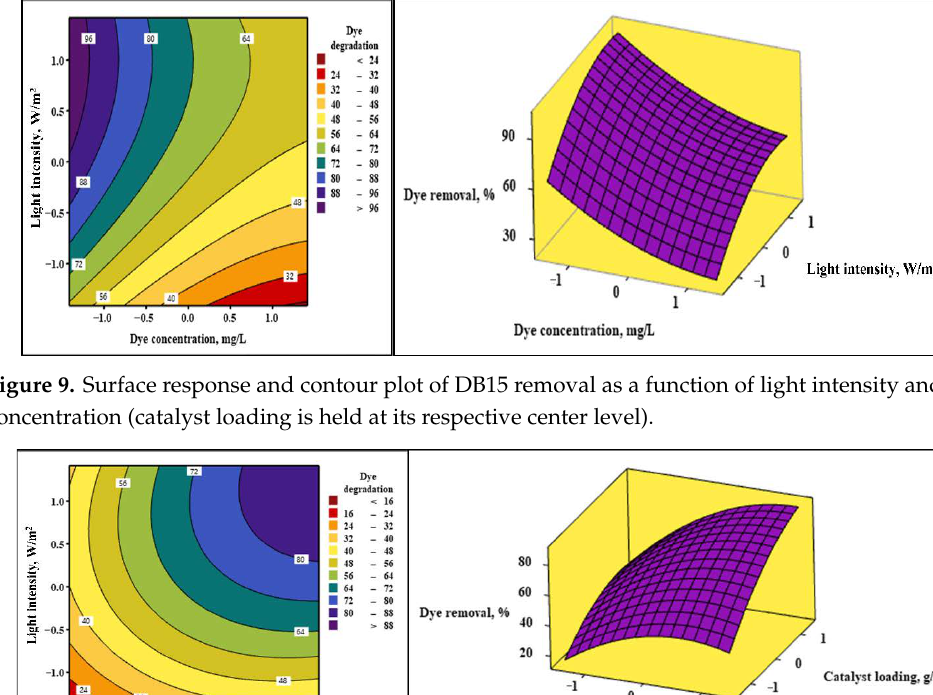
Figure 8. Surface response and contour plot of DB15 removal as a function of catalyst and dye concentration (light intensity is held at its respective center level).